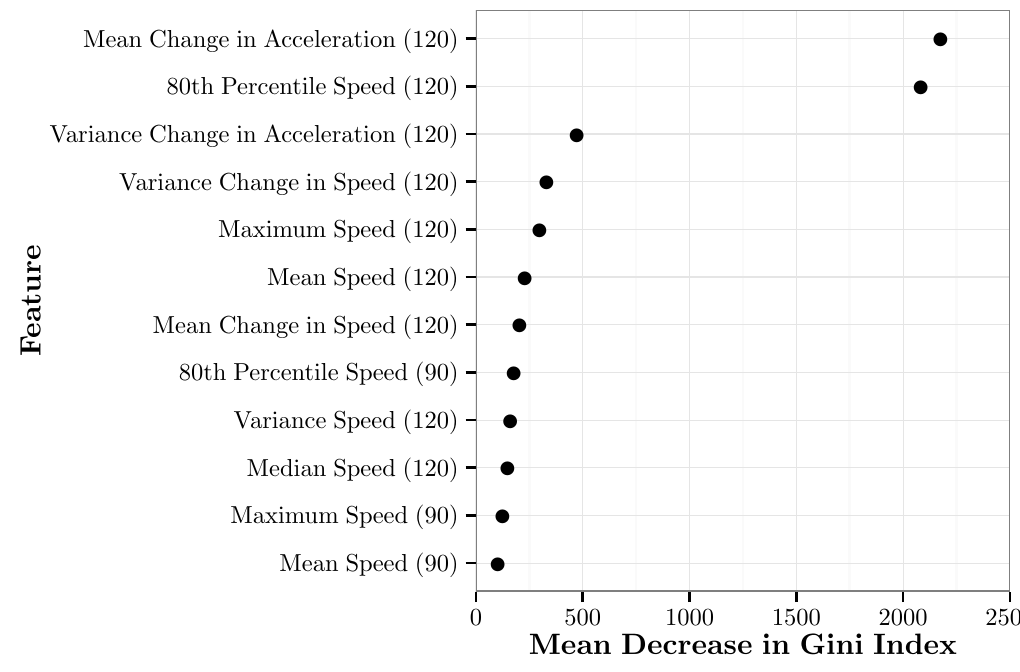
Figure 11. The mean decrease in the Gini index for each of the top 12 features in RFE-RF{12}.